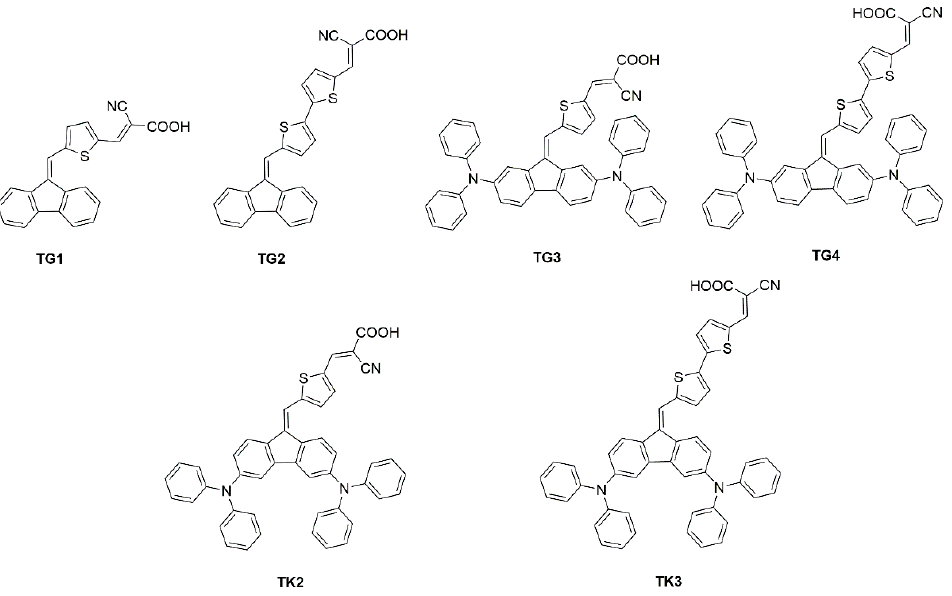
Figure 7. Dibenzofulvene (DBF)-based organic-dyes. TG1 and TG2 are two basic structures without donor groups on the DBF unit, and containing one or two thiophene rings, respectively, as spacer between the ylidene system and the cyanoacrylic acceptor unit. TG3 and TG4 can be considered as deriving from TG1 and TG2 , respectively, with the introduction of the diphenylamine donor unit in the 2,7-positions of the DBF structure. TK2 and TK3 , instead, can be considered as deriving from TG1 and TG2 , respectively, with the introduction of diphenylamine donor unit in the 3,6-positions of DBF structure. The absorption spectra of dyes recorded in CH 2 Cl 2 are reported in Figure 8 as molar absorption coefficient ε .